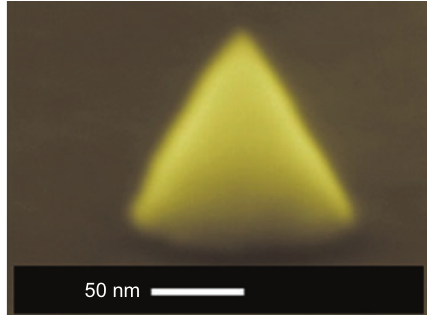
Figure 20 Gold nanocone fabricated by etch mask transfer litho- graphy. Image by M.